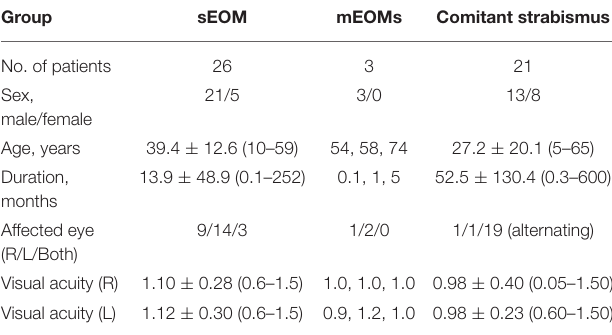
TABLE 6 | Characteristics of patients with idiopathic cause.